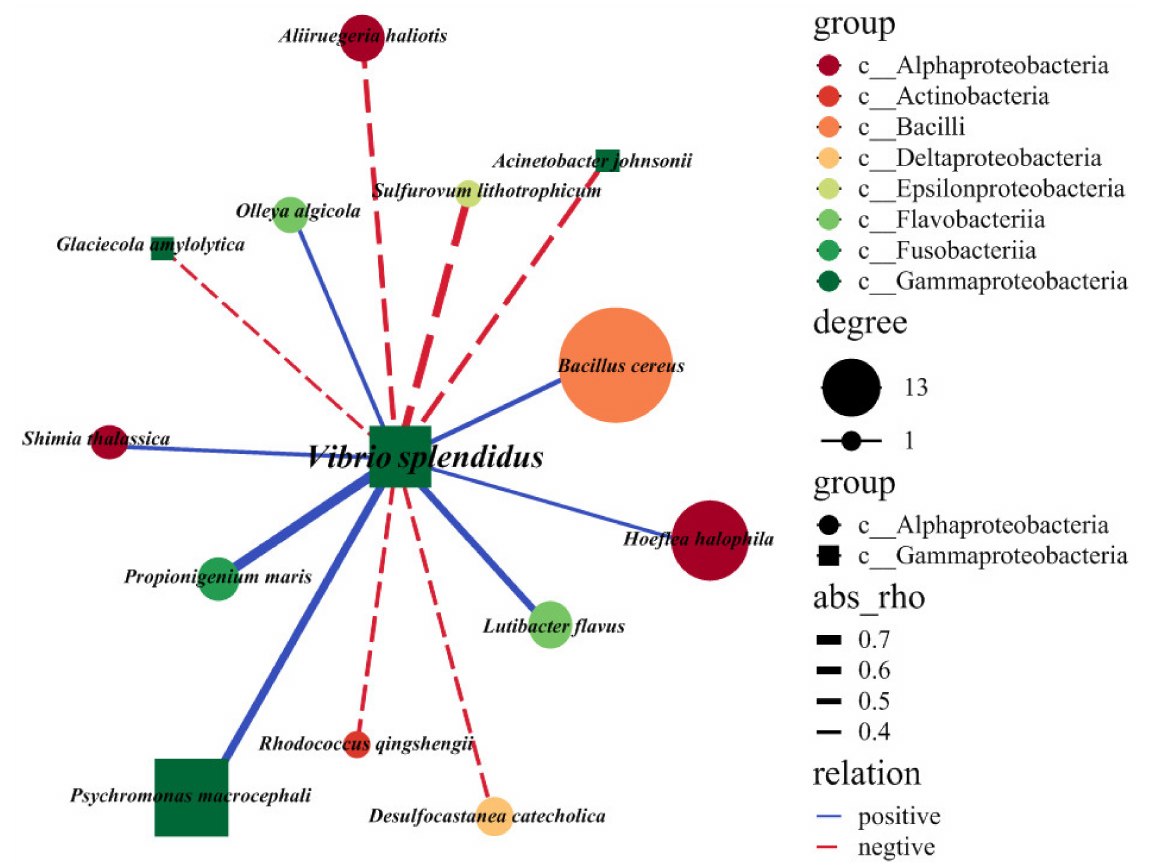
Figure 4. Microbial interaction networks of V. splendidus with other major bacterial species through- out the infection of sea cucumber. The solid (or dashed) arrows represent positive (or negative) interactions between the two individual bacteria. The sizes of the circles were proportional to the abundance of that bacteria. OTUs are colored to indicate the bacterial class level. The edge thickness is proportional to the value of Spearman’s